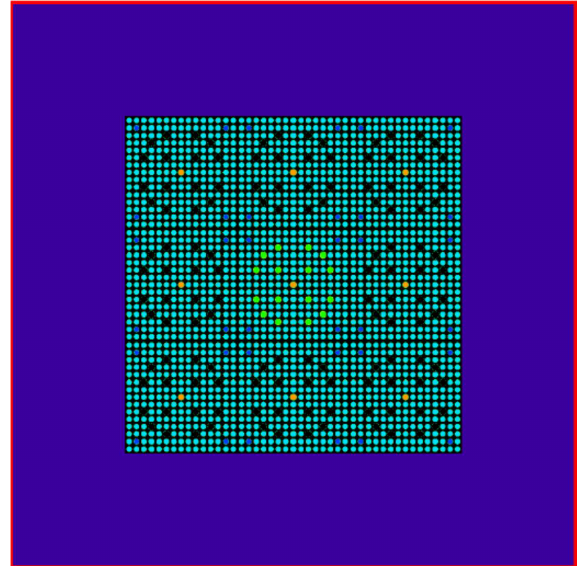
Fig. 4. TMI Minicore cross-section material